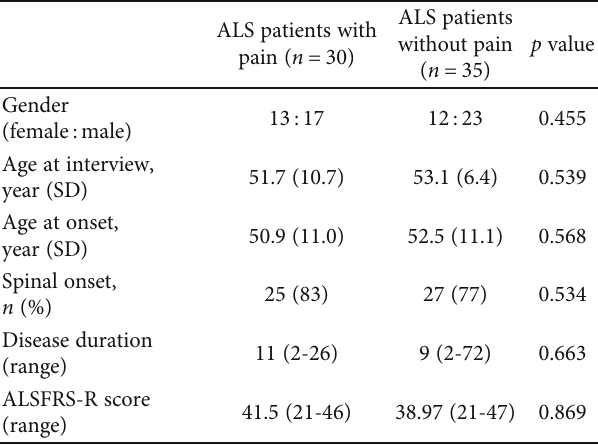
Table 3: Clinical characteristics of ALS patients with pain or without pain.